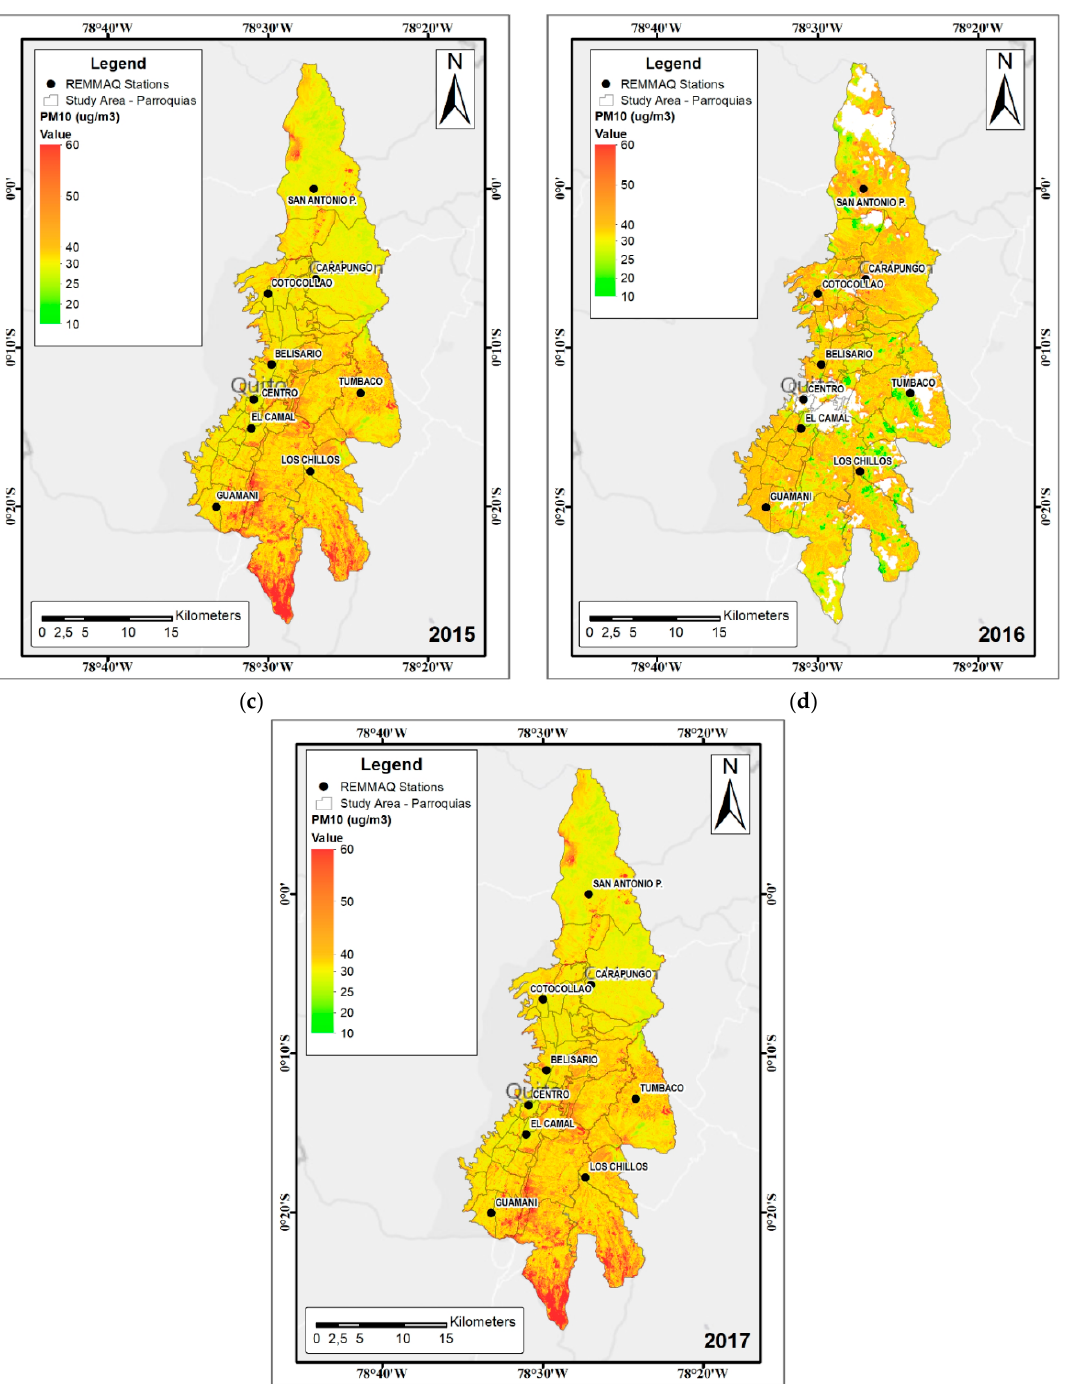
Figure 6. PM10 concentrations during the season 4 (July to September) with Landsat-8 LUR-MLP model in: ( a ) 2013; ( b ) 2014; ( c ) 2015; ( d ) 2016; ( e ) 2017. The white gaps represent areas with a high cloud density.